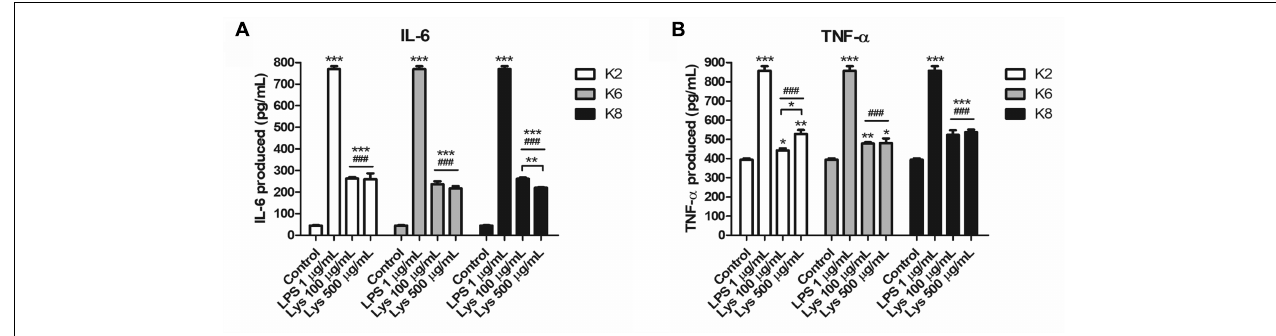
FIGURE 6 | Induction of (A) IL-6 and (B) TNF- α by lysates of L. plantarum ATG-K2, ATG-K6, and ATG-K8 in RAW264.7 murine macrophage cells. The means of triplicated wells are shown from duplicated experiments ± SEM. Statistical significance in the figures are as follows: compared to control, ∗ p < 0.05, ∗∗ p < 0.01, and ∗∗∗ p < 0.001; compared to the LPS group ### p < 0.001. Significant differences between doses in the same group are shown with directional lines as ∗ p < 0.05 and ∗∗ p < 0.01.